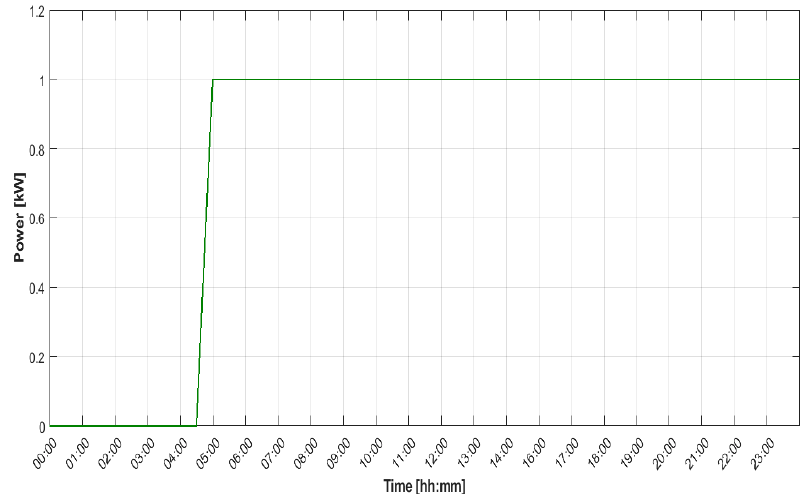
Figure 6. Load curve of the technical room.